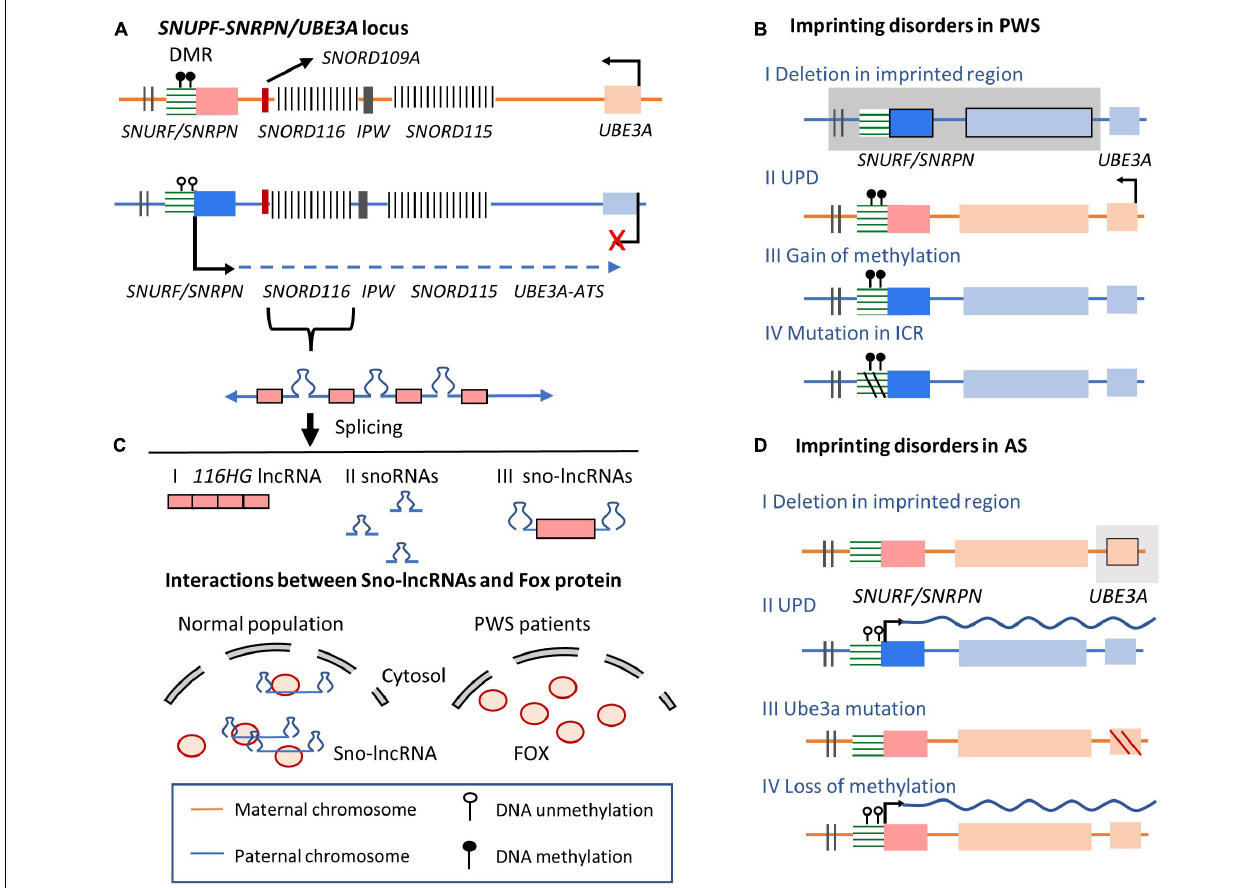
FIGURE 4 | SNUPF-SNRPN/UBE3A imprinted cluster on human chromosome 15 and related imprinting disorders. (A) Allelic expression pattern in SNUPF-SNRPN/UBE3A locus. On the maternal allele, the methylation of ICR silences the expression of UBE3A-ATS , permitting UBE3A expression. On the paternal allele, UBE3A-ATS is expressed from the SNURF gene region, overlapping the exon region of UBE3A gene. On the paternal allele, lncRNA host transcript are processed to give rise to snoRNAs ( SNORD115 and SNORD116 ), lncRNAs ( 116HG , 115HG , and UBE3A-ATS ). Three different spliced non-coding transcripts are produced from SNORD116 gene locus, including 116HG lncRNA, snoRNAs, and sno-lncRNAs. SNORD116 sno-lncRNAs with snoRNAs on two ends are produced after splicing. (B) Imprinting disorders occur in PWS. PWS-related molecular alterations in UBE3A imprinted gene cluster. Line I indicates deletion in the imprinted region; Line II shows double maternal alleles are inherited, losing the paternal copy; Line III shows that the epigenetically mutated DNA methylation in DMR of the ICR leads to the silencing of lncRNA expression. Line IV: small deletion within the ICR. (C) Sno-lncRNAs transcribed from paternal allele can recruit Fox proteins and other related proteins, regulating Fox protein distribution and related alternative splicing functions. However, in PWS patients, loss of the UBE3A-ATS and other noncoding gene expression lead to the accumulation of Fox proteins in the nucleus and global abnormal splicing patterns. (D) Imprinting disorders occur in AS. Line I: deletions of the maternal imprinted regions containing the UBE3A and surrounding genes; Line II: both alleles are inherited from paternal chromosome; Line III: UBE3A mutations lead to transcript loss of function; Line IV: epimutations in the maternal allele lead to lncRNA expression from the maternal allele, preventing normal UBE3A